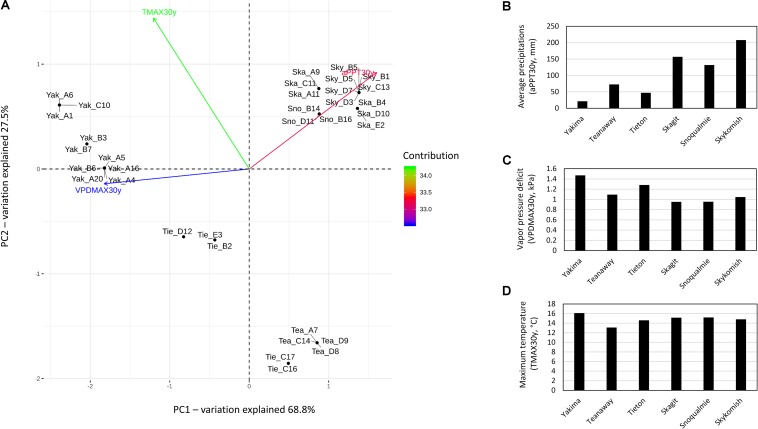
Principal component analysis and trends on 30 year climate data, max temperature, average precipitations and max vapor pressure deficit in Yakima (Yak), Tieton (Tie), Teanaway (Tea), Snoqualmie (Sno), Skagit (Ska) and Skykomish (Sky) sampling sites. (A) Principal component analysis if 30 year climate data; the total contribution to PC1 and PC2 of max temperature (TMAX30y), average precipitations (aPPT30y) and maximum vapor pressure deficit (VPDMAX30y) on the first and second component are encoded in color scale. (B–D) trends of 30 year climate data, samples are grouped by sampling sites: Yakima, Teanaway, Tieton, Skagit, Snoqualmie and Skykomish.